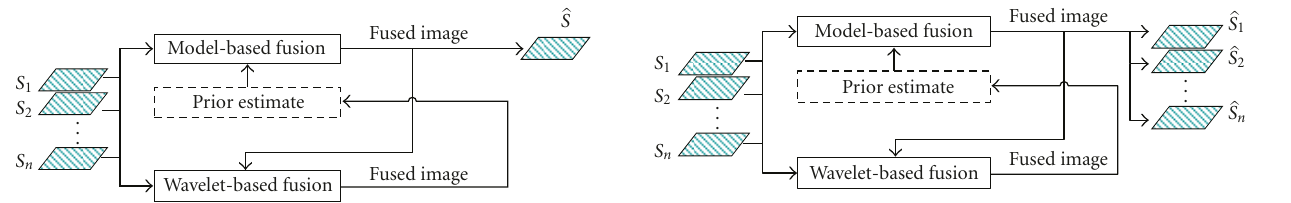
Figure 10: Framework of multi-multi turbo